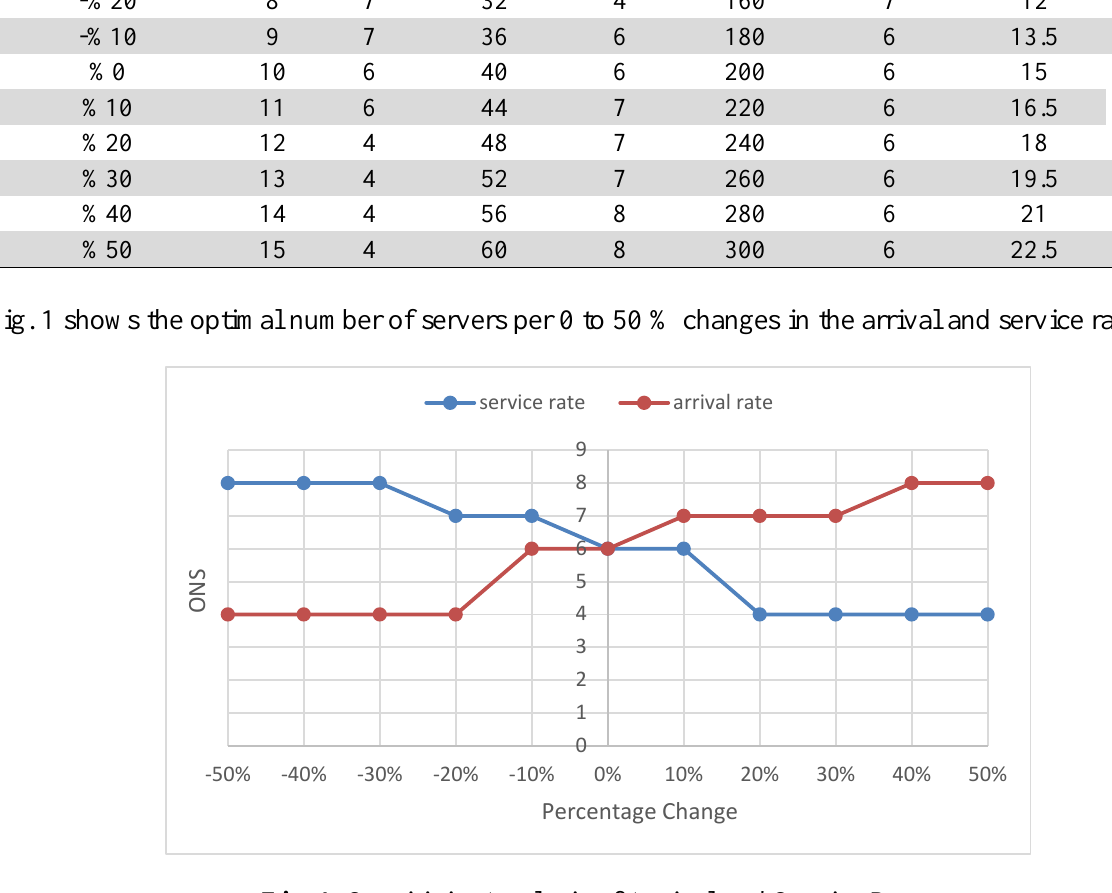
Fig. 1. Sensitivity Analysis of Arrival and Service